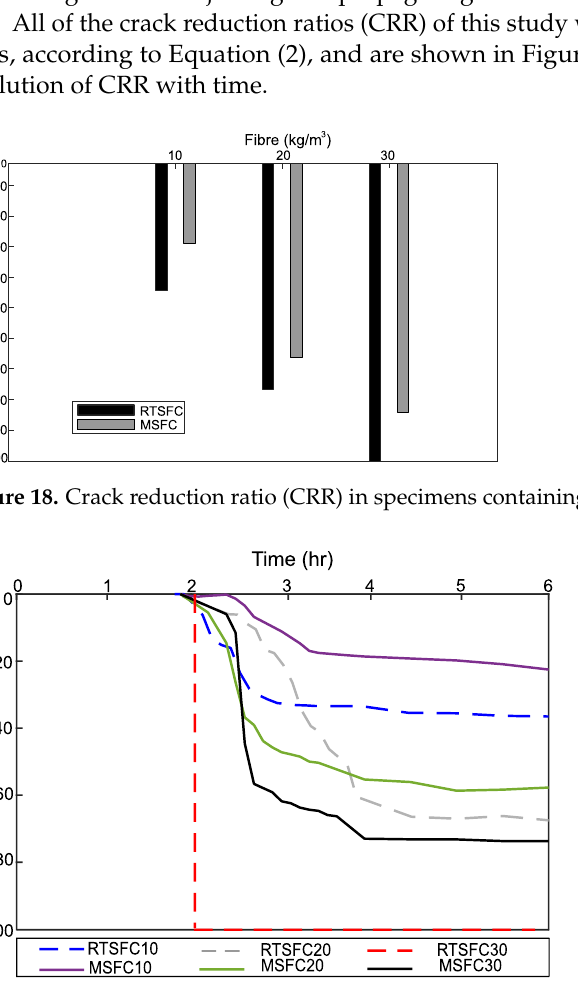
Figure 20. Location of the cross-section of RTSF and MSF slabs (red dashed line).